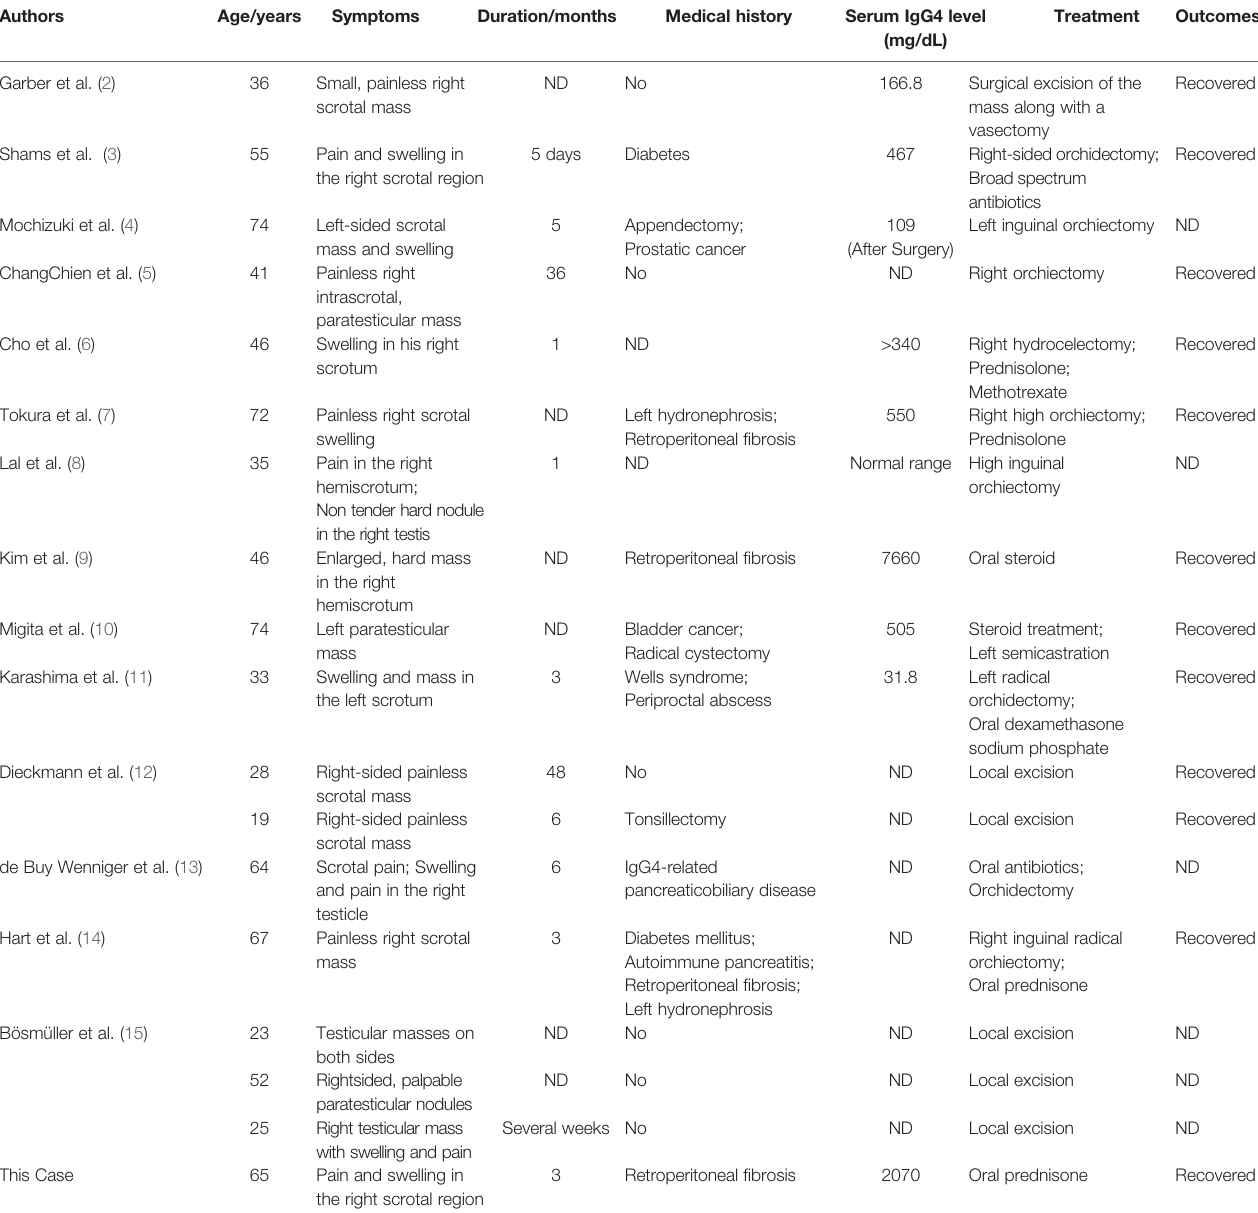
TABLE 1 | Clinical characteristics of 18 patients with testicular involvement of IgG4-related